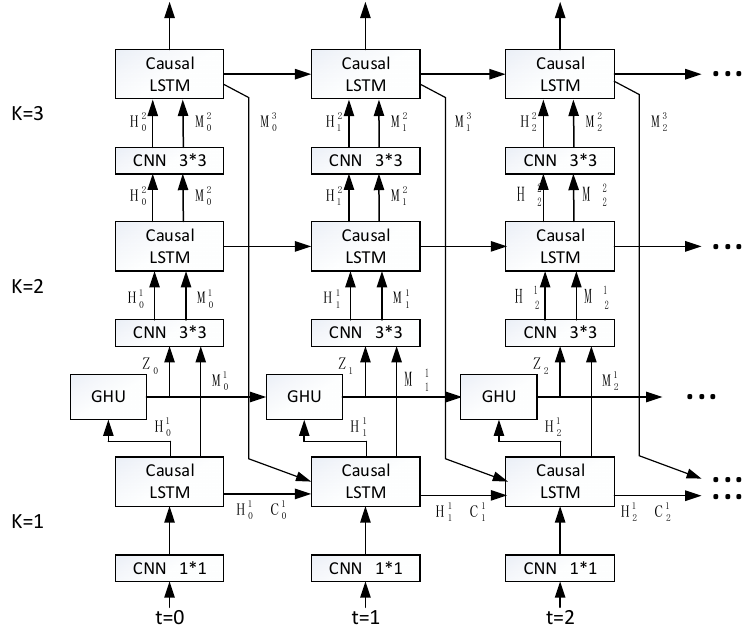
Figure 5. Encoding layer structure.